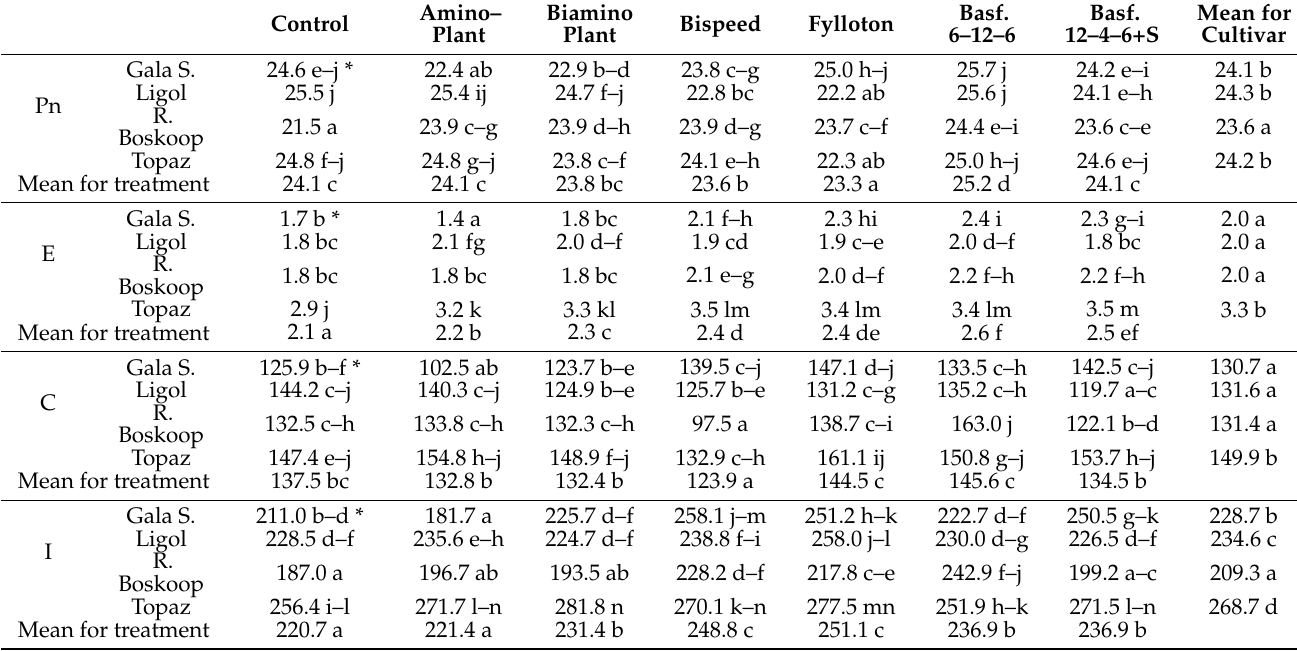
Table 4. Physiological parameters of maiden apple trees depending on treatment and